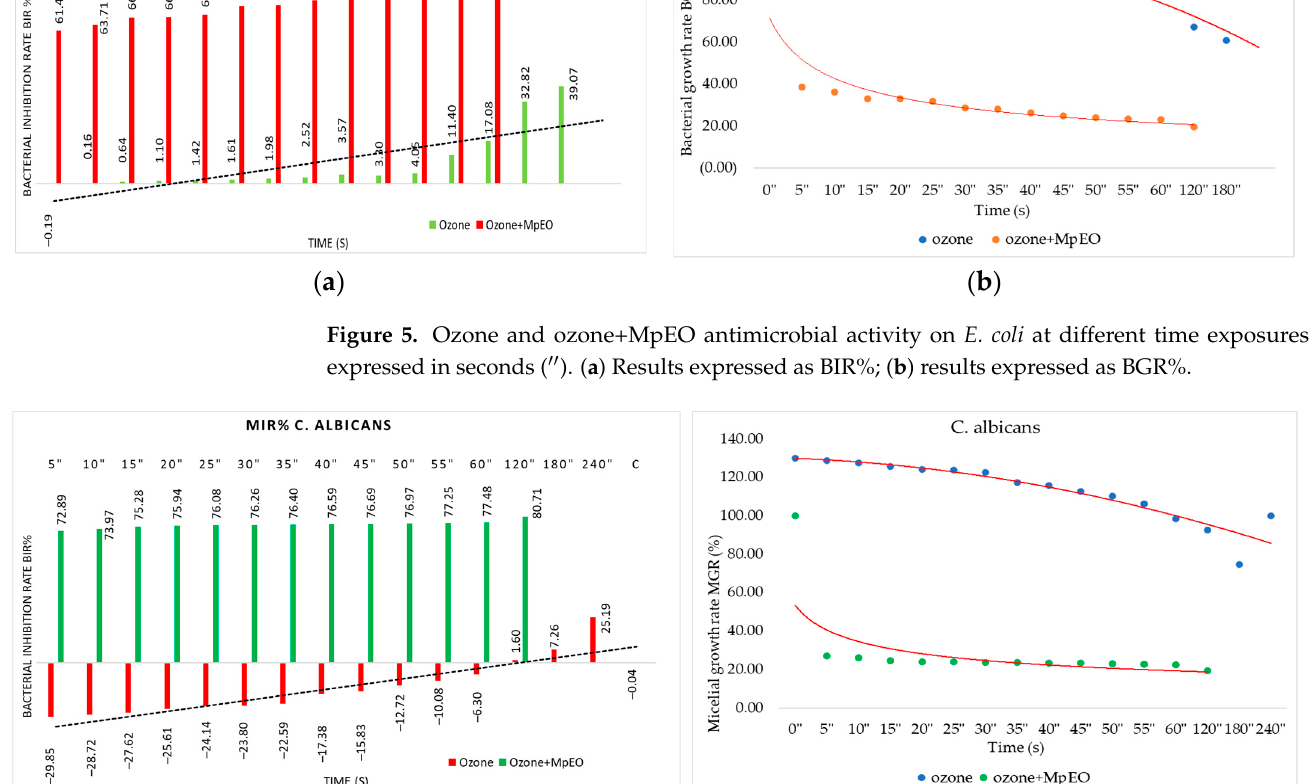
Figure 4. Ozone and ozone+MpEO antimicrobial activity on P. aeruginosa at different time exposures